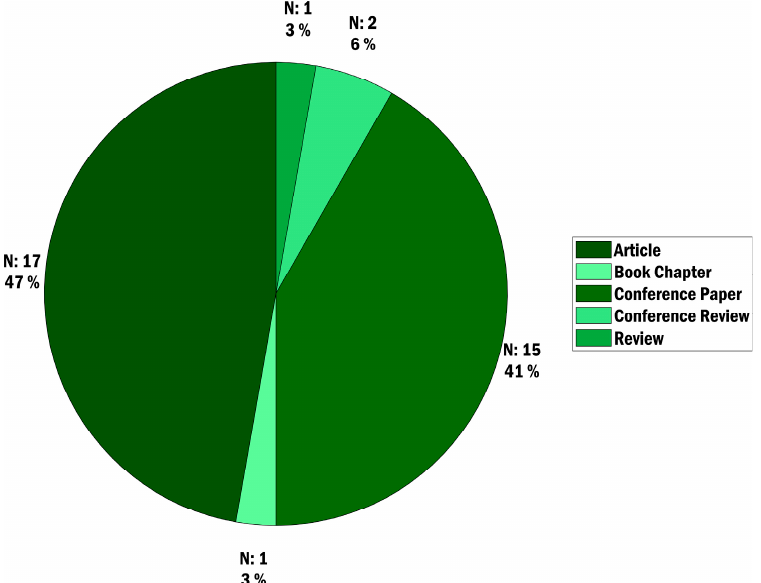
Appl. Sci. 2023 , 13 , x FOR PEER REVIEW